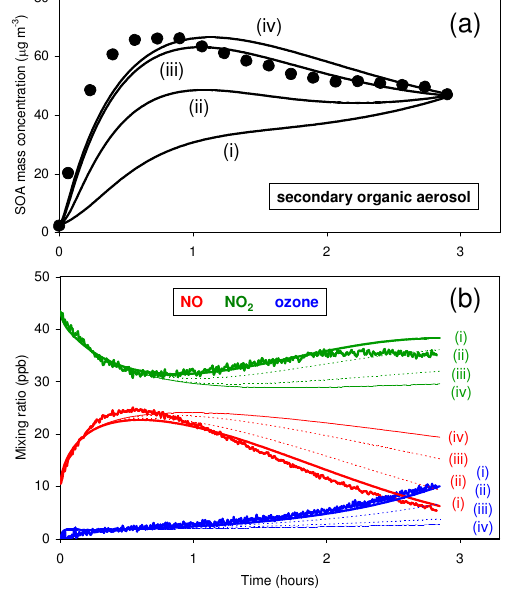
Figure 13. Time profiles of: (a) secondary organic aerosol (SOA) mass concentration; and (b) NO, NO 2 and ozone; for ACES photo-oxidation experiment 03-07-08. The observed profiles are as in Figs. 11 and 12. The lines are simulations showing the impact of uniform reductions in p L q , with the following scaling factors: (i) 1.0; (ii) 0.3; (iii) 0.1 and (iv) 0.05. In each case, the value of [wall] eff was optimised to recreate the final SOA mass loading, leading to [wall] eff values of: (i) 1.5 mg m -3 ; (ii) 3.3 mg m -3 ; (iii) 6.6 mg m -3 ; and (iv) 10.3 mg m -3 .